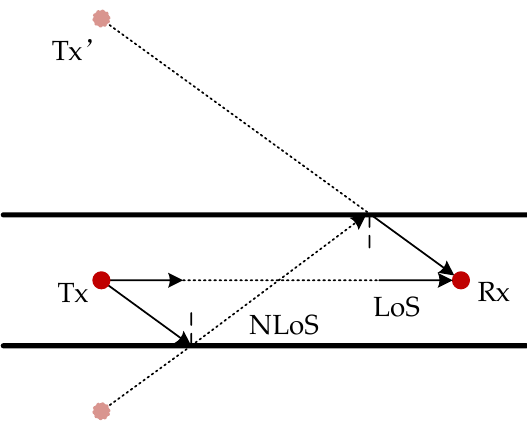
Figure 3. Channel model based on spatial mirror method.